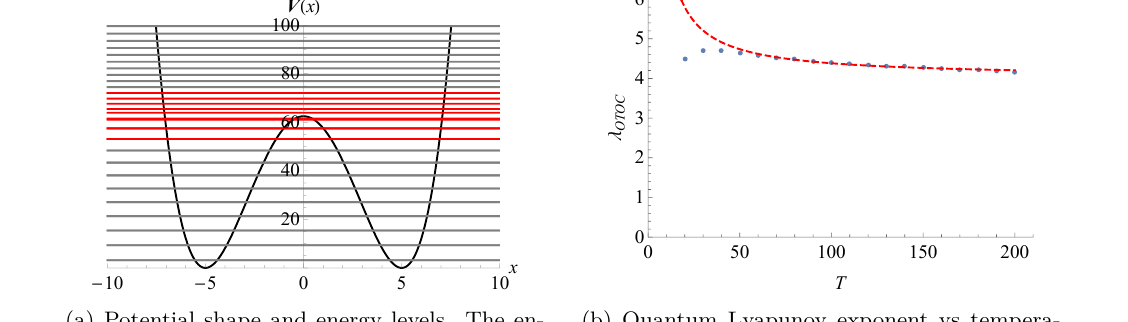
Figure 5 . Inverted harmonic oscillator potential for λ = 2